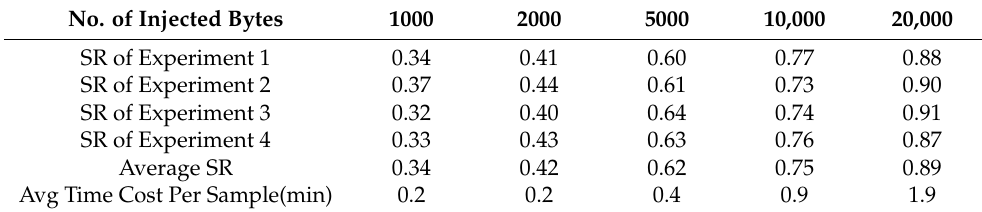
Table 3. SR of the proposed method adopting the end-of-file strategy.